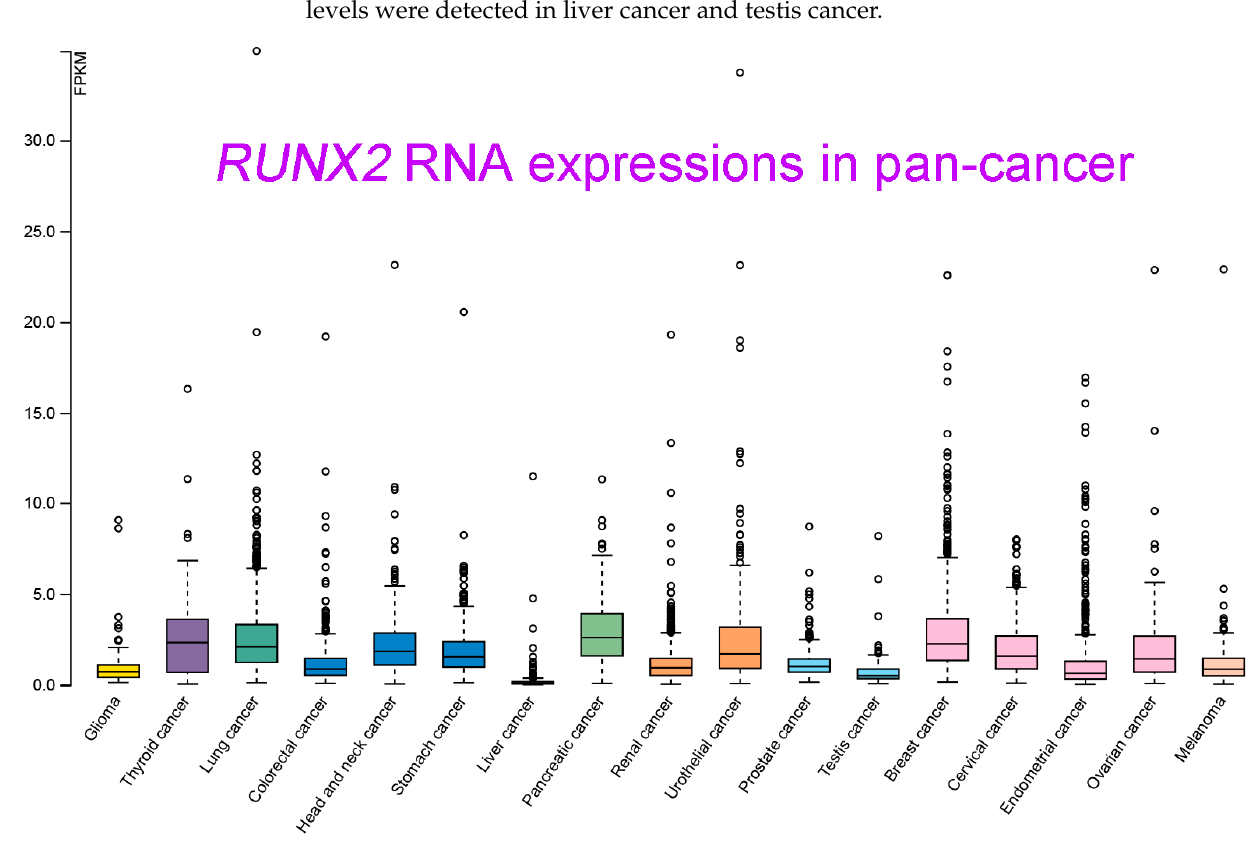
Figure 5. RUNX2 RNA-seq data in 17 cancer types (TCGA) were re-analyzed. These transcript expression data were obtained by RNA-Seq analyses based on the data retrieved from the TCGA database and were normalized and used to assess relative RUNX2 expression in various types of cancers. Data are shown as the median number of fragments per kilobase per million (FPKM). Normal distribution in the dataset is represented by the box plots, and the points represent the data of outliers if the expression levels are below or above 1.5 times the interquartile range. Data were adapted with permission from HPA (https://www.proteinatlas.org/about/licence#citation_guidelines_for_the_ human_protein_atlas, accessed on: 21 February